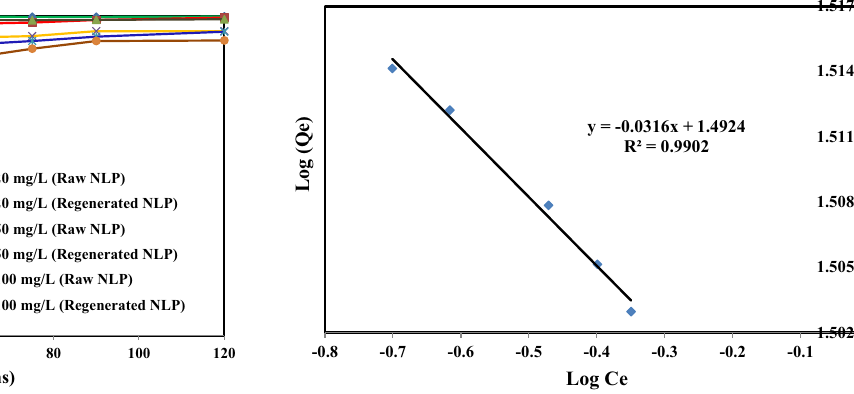
Fig. 12 Freundlich adsorption-isotherm of MG (NLP: 3 g/l, pH: